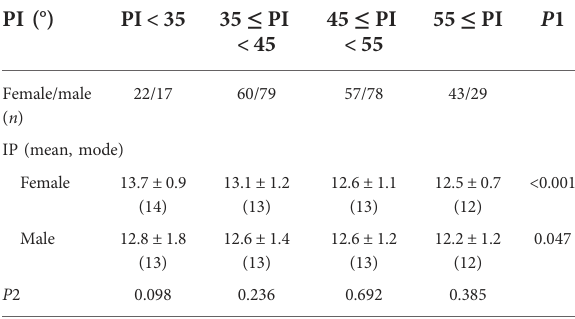
TABLE 1 Description of demographic and sagittal spinopelvic